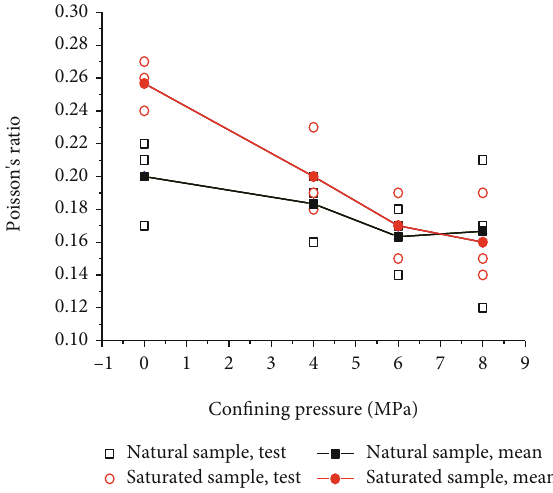
Figure 9: Postpeak strain of natural and saturated rock samples under di ff erent con fi ning